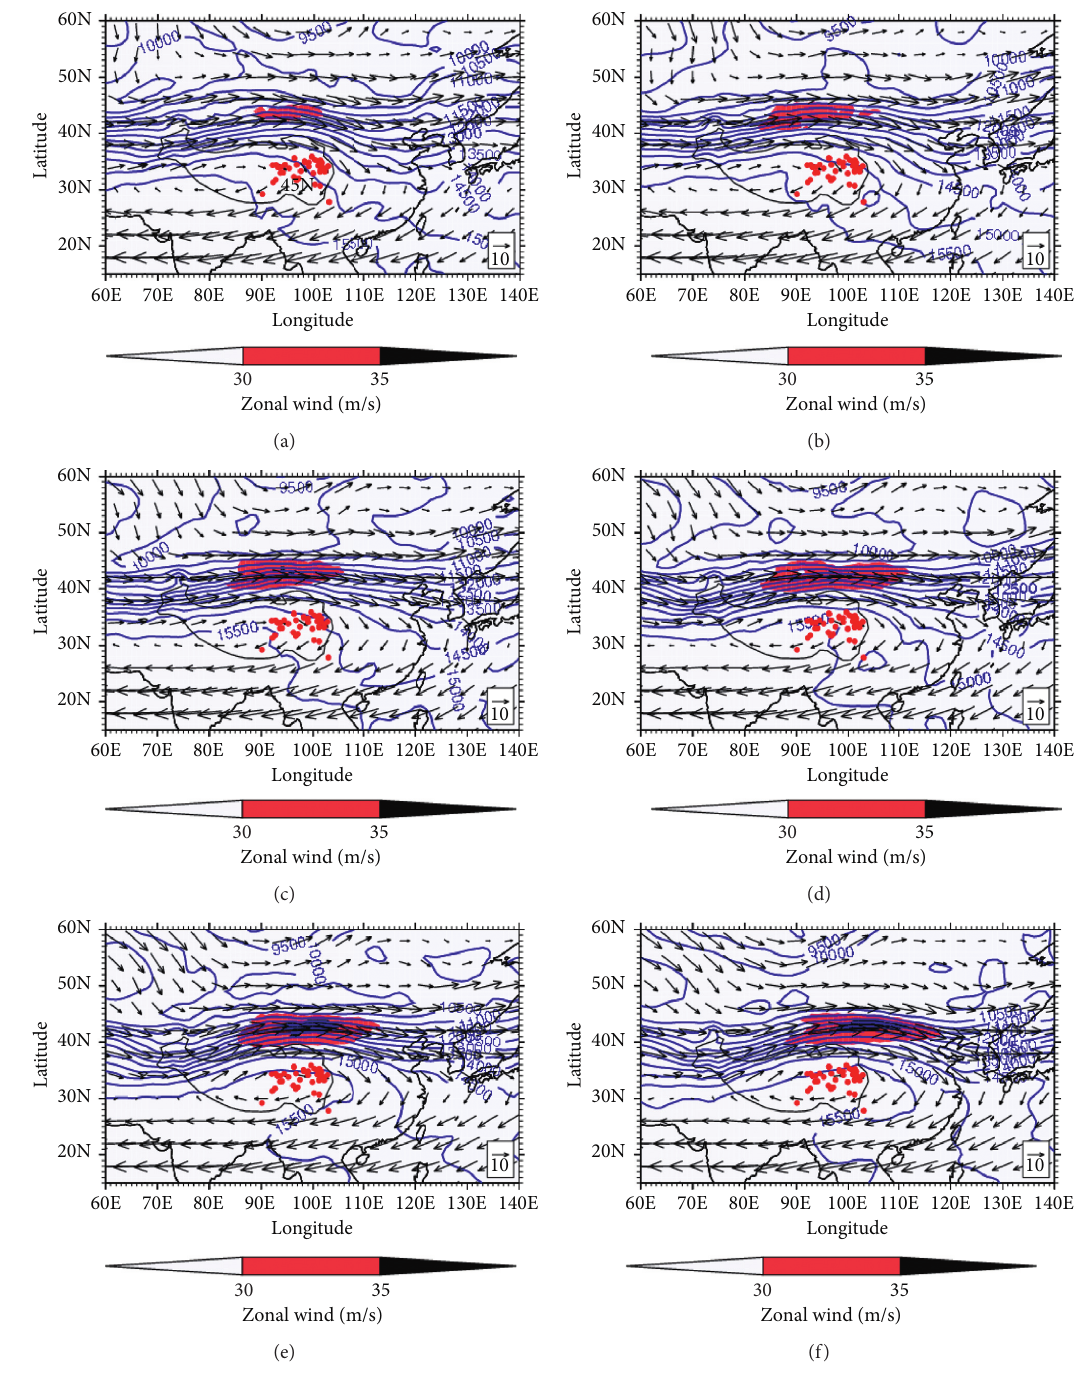
Figure 6: The composites of geopotential height (units: gpm, blue lines) and wind fields (black arrow, and color contours indicate the areas where the zonal wind speed is greater than 30 m/s) on the dynamic tropopause height (3.5 PVU) for the (a) 5th day, (b) 4th day, (c) 3rd day, (d) 2nd day, (e) 1st day, and (f) 0 day before the OCS onset for 41 OCS. The red dots indicate the locations of the 41 OCS